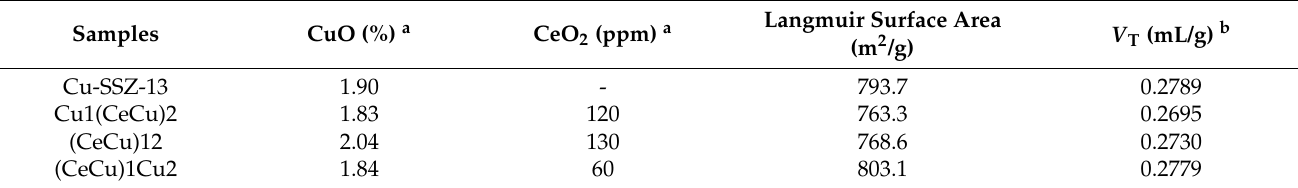
Figure 2. XRD profiles of Cu ‐ SSZ ‐ 13 and Ce ‐ modified Cu ‐ SSZ ‐ 13 catalysts.